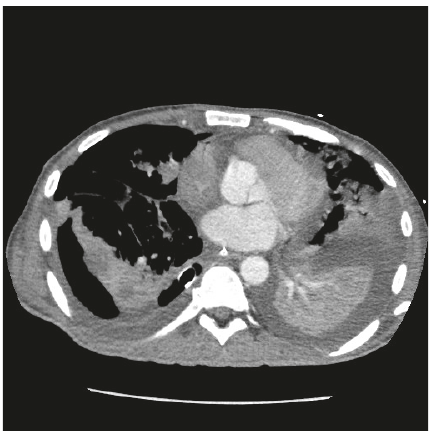
Figure 1: CT on admission showing a large right sided pleural effusion containing pockets of gas along with focal airspace disease within the lingula and left lower lobe.